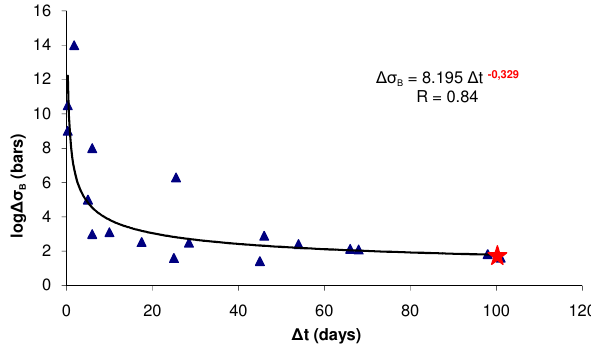
Fig. 2. The plot of the power law between the stress drop of the earthquakes and the lead time of SES. A red star corresponds to the new data (Table 1) while solid triangles refer to the data sets reported by Dologlou (2010, 2012). The derived power law relation along with its correlation coefficient R and the exponent α = 0 . 329 are displayed on the top of the